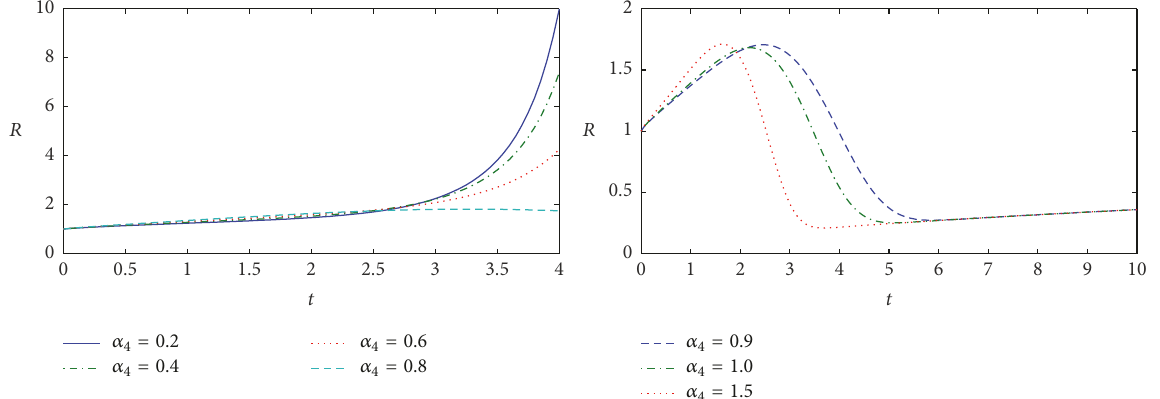
Figure 4: Variation of scale factor against time for fixed 𝛼 2 = 0.5 and different 𝛼 4